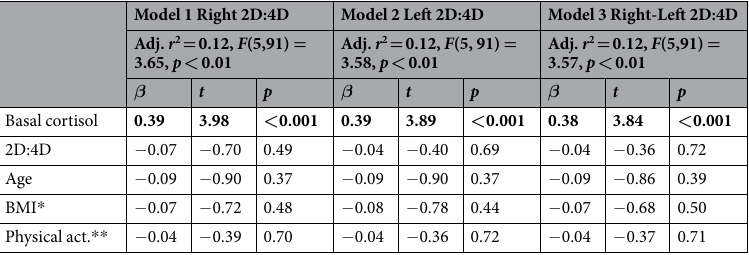
Table 1. A summary of the pre-exercise testosterone regression results. Significant results are bolded (N = 97). * BMI – Body Mass Index; ** Physical act. – physical activity during a typical week (number of trainings per week * typical length of a training).